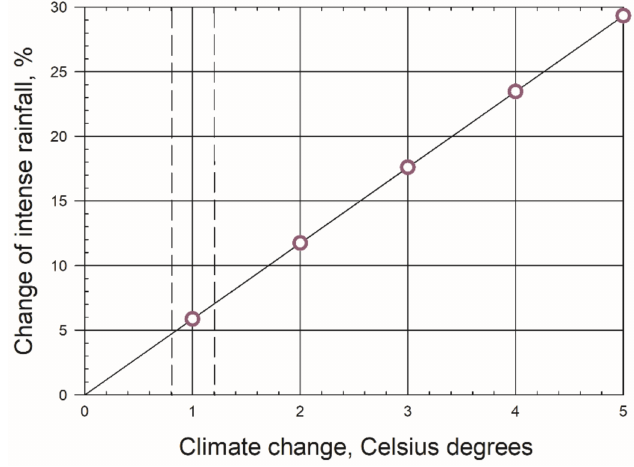
Figure 11. Change of intense rainfall depth in % due to change of the predictors of temperature in the equation for R : the predictor of temperature (T2) was increased by +1 to +5 ◦ C and the change of the rainfall intensity was calculated using 8438 rain intensity values. Vertical lines: human activities are estimated to have caused approximately 1.0 ◦ C of global warming above pre-industrial levels, with a likely range of 0.8 to 1.2 ◦ C according to [27]. Table 6. Increased rain amount in percent due to increased temperature. Results are based on 8438 rain intensity values. Statistical Parameters Temperature Change: Degrees CELSIUS: Unit: Percent (%) Relative to +1 +2 +3 +4 +5 the Unchanged Climate. Minimum 3.17